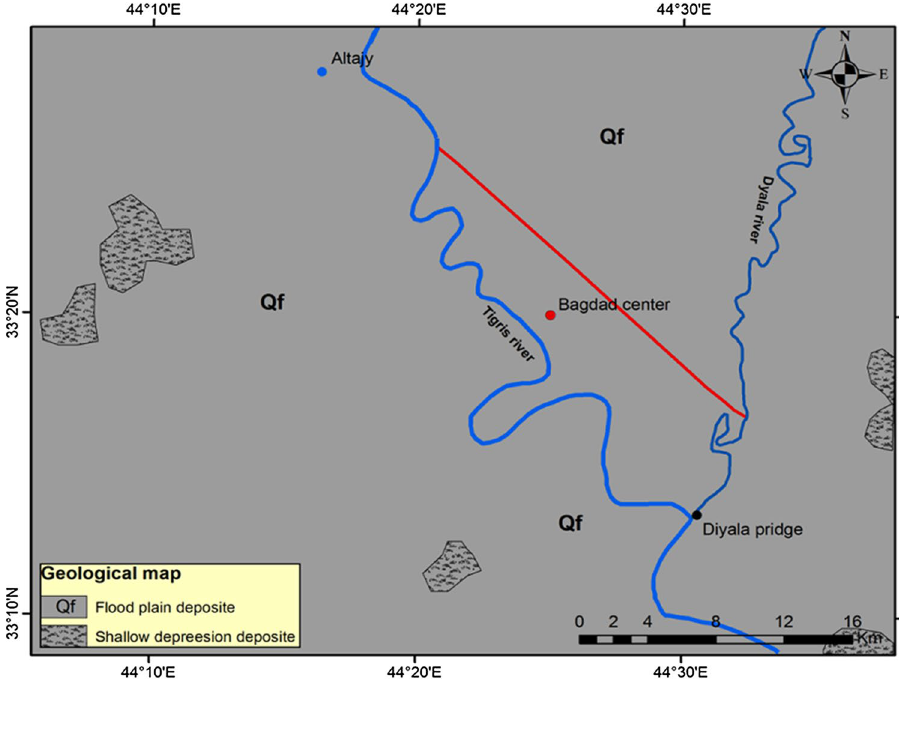
Fig. 3 Digital elevation model, DEM, of the study